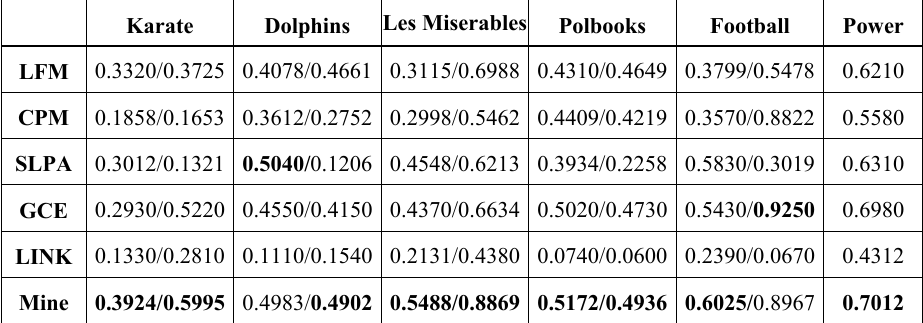
Table 2. Formatting sections, subsections and